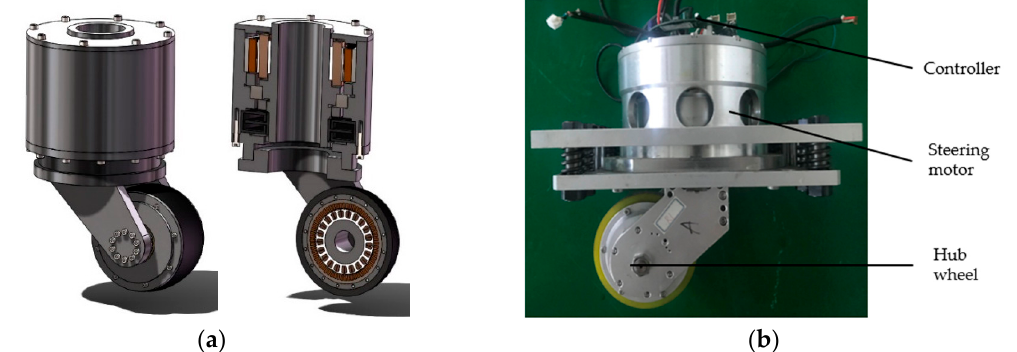
Figure 1. The designed direct driving powered caster wheel (PCW). ( a ) Schematic figure of the PCW; ( b ) prototype of the PCW.